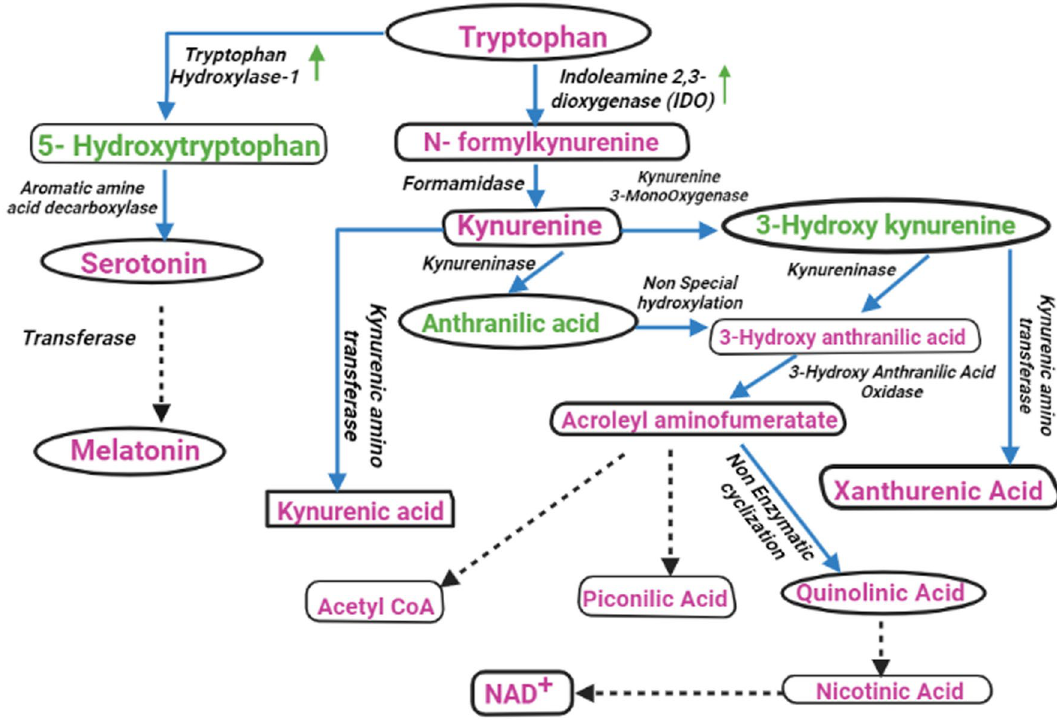
Figure 12. Potential pathway modulations of tryptophan metabolism and the derived metabolites during early gestation in Murrah buffaloes. The figure is created in